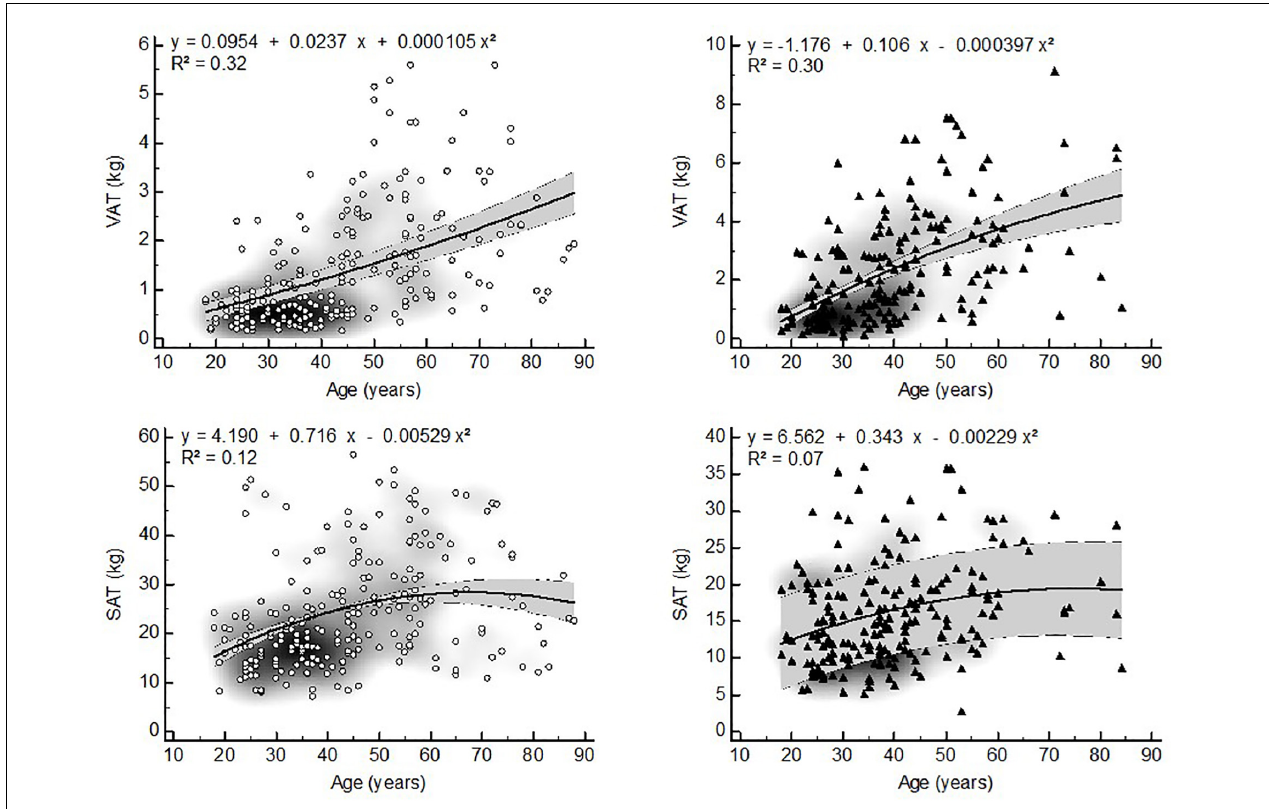
FIGURE 5 | Non-linear relationships between VAT, SAT and age ( (cid:78) = women, (cid:78) = men, VAT = visceral adipose tissue, SAT = subcutaneous adipose tissue, gray zone represents 95% confidence